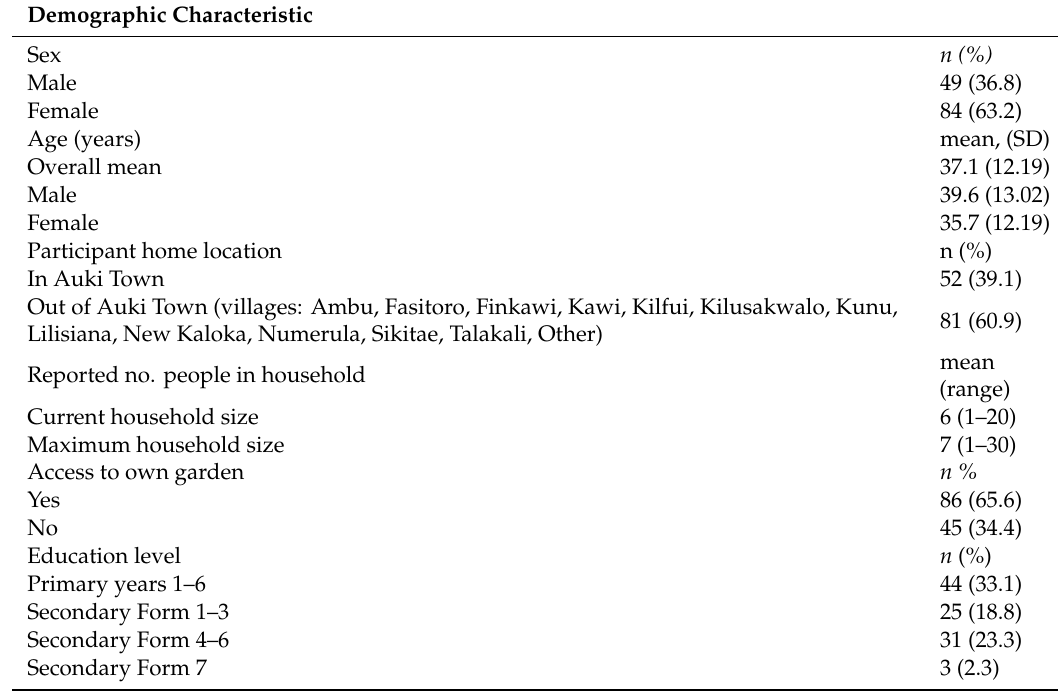
Table 1. Participant demographic